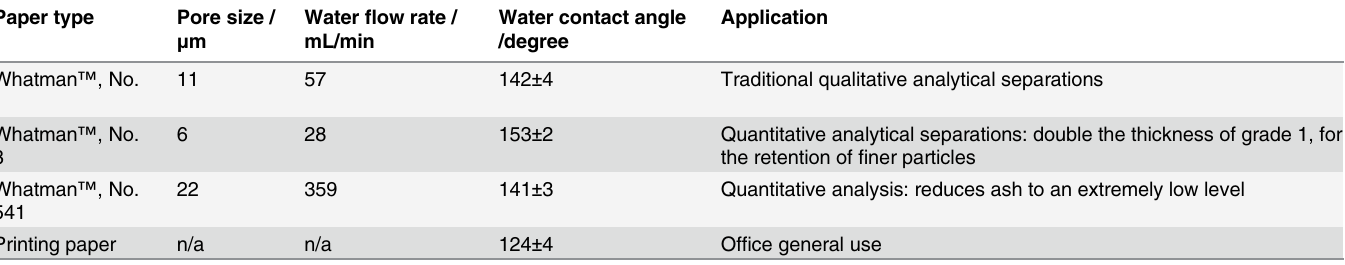
Table 1. Modification of different types of filter paper and standard printing paper. The pore sizes and flow rates [28] are listed for comparison. Paper